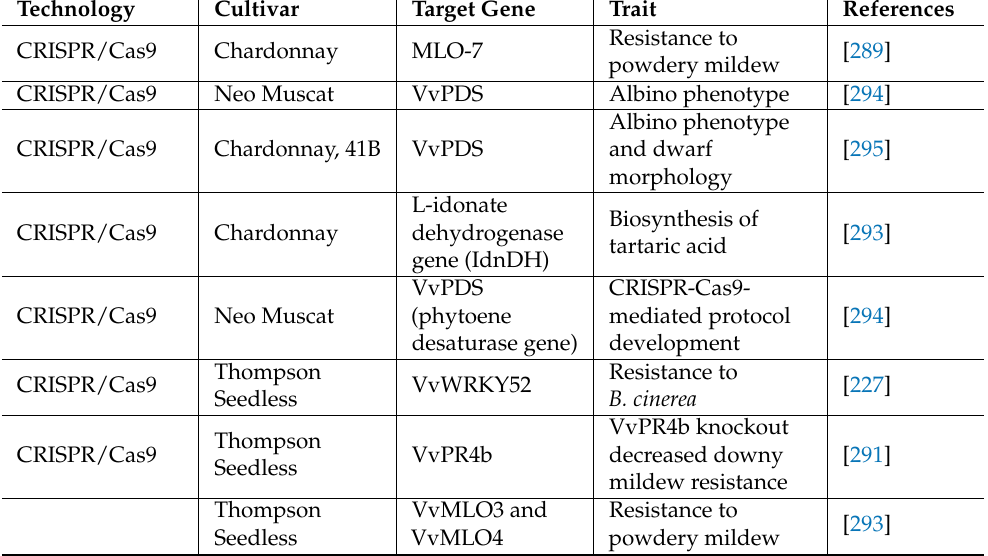
Table 3. Grapevine improvements with CRIPSR-Cas9 technology (modified from Zhang et al. [17]; Butiuc-Keul et al.